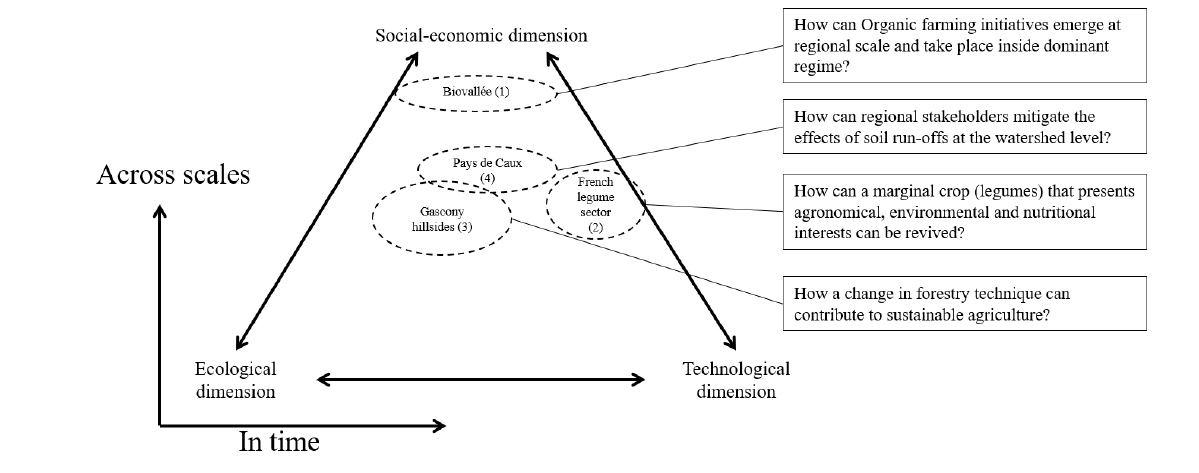
Fig. 4. Position of the selected case studies according to the socioeconomic, ecological, and technological dimensions